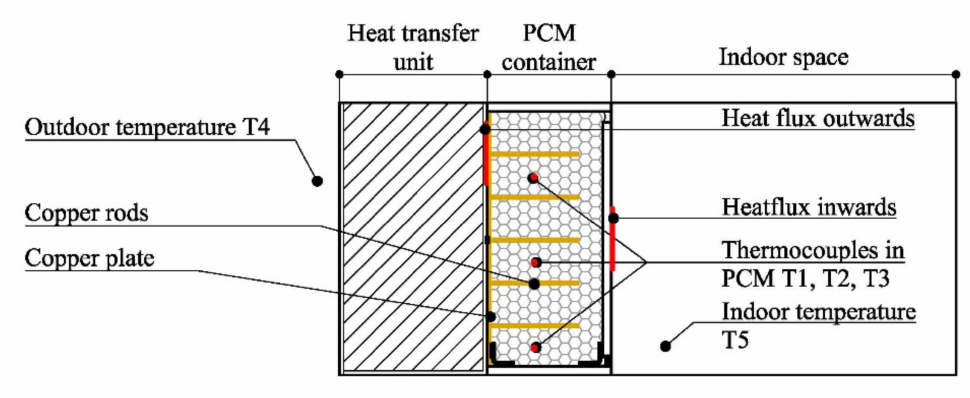
Figure 5. Measuring equipment.